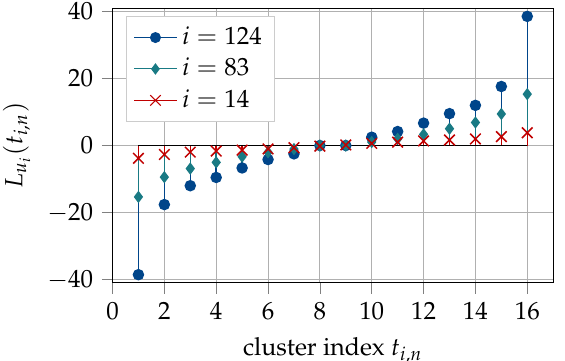
Figure 9. Translation tables of an information bottleneck decoder with |T | = 16 for different bit channels of a half-rate polar code with N = 128, design E b / N 0 = 3 dB. u 14 is a frozen bit while u 83 , and u 124 are information